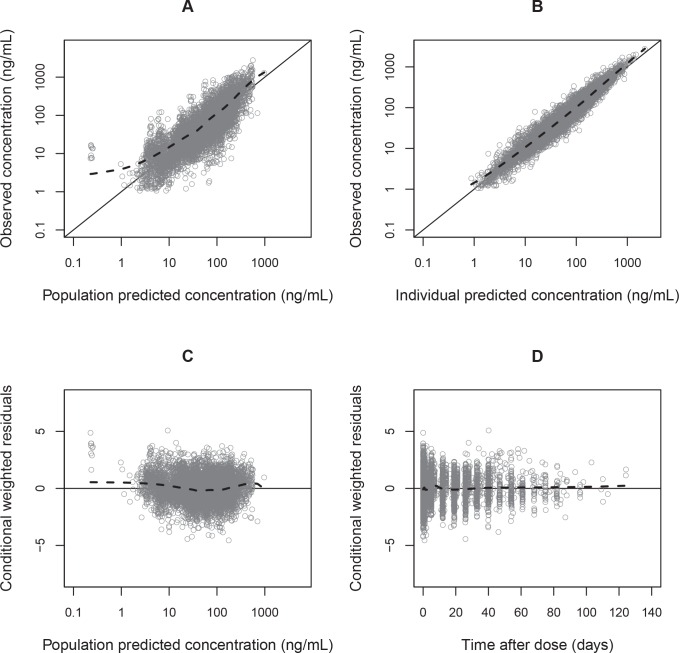
Basic goodness-of-fit plots for the final piperaquine model.Observed plasma piperaquine concentrations (from 11 clinical studies) plotted against population predicted concentrations (A) and against individual predicted concentrations (B). Conditional weighted residuals plotted against population prediction (C) and time (D). The solid line is the identity line, and the dashed line is the locally weighted least squares regression line.